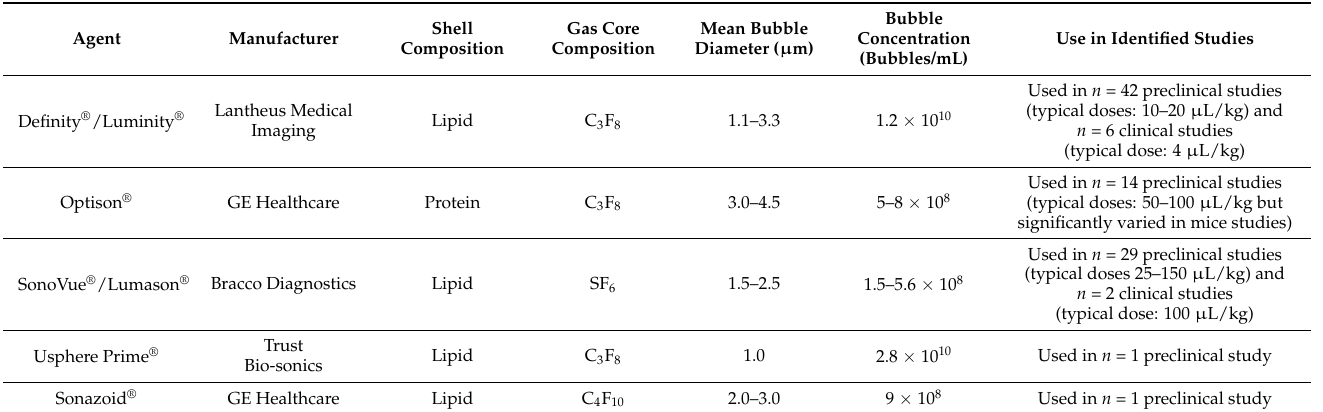
Table 3. Comparison of five major commercially available microbubble formulations used in studies for ultrasound-mediated BBB disruption (information sourced from manufacturer) and typical